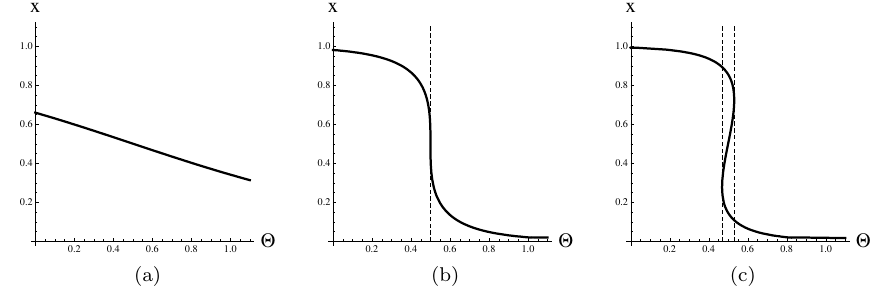
Figure 3. The dependence of x of Θ for a) µ ∈ (0;4) , b) µ = 4 and c) µ ∈ (4; ∞ ) , vertical dashed lines for Θ 1 and Θ 2 .